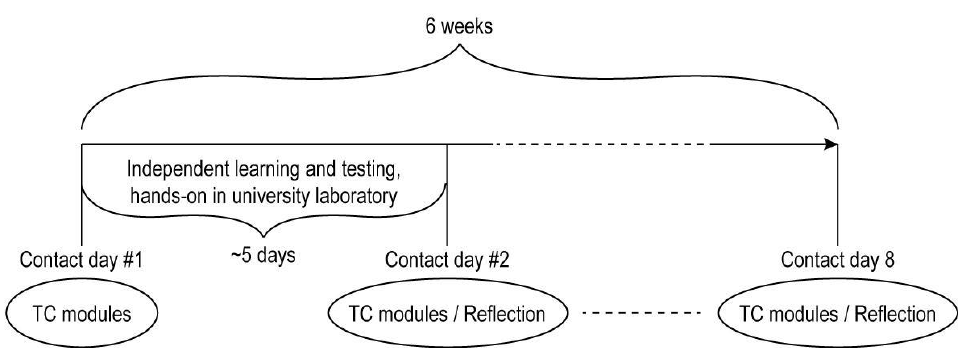
Figure 6. Training course